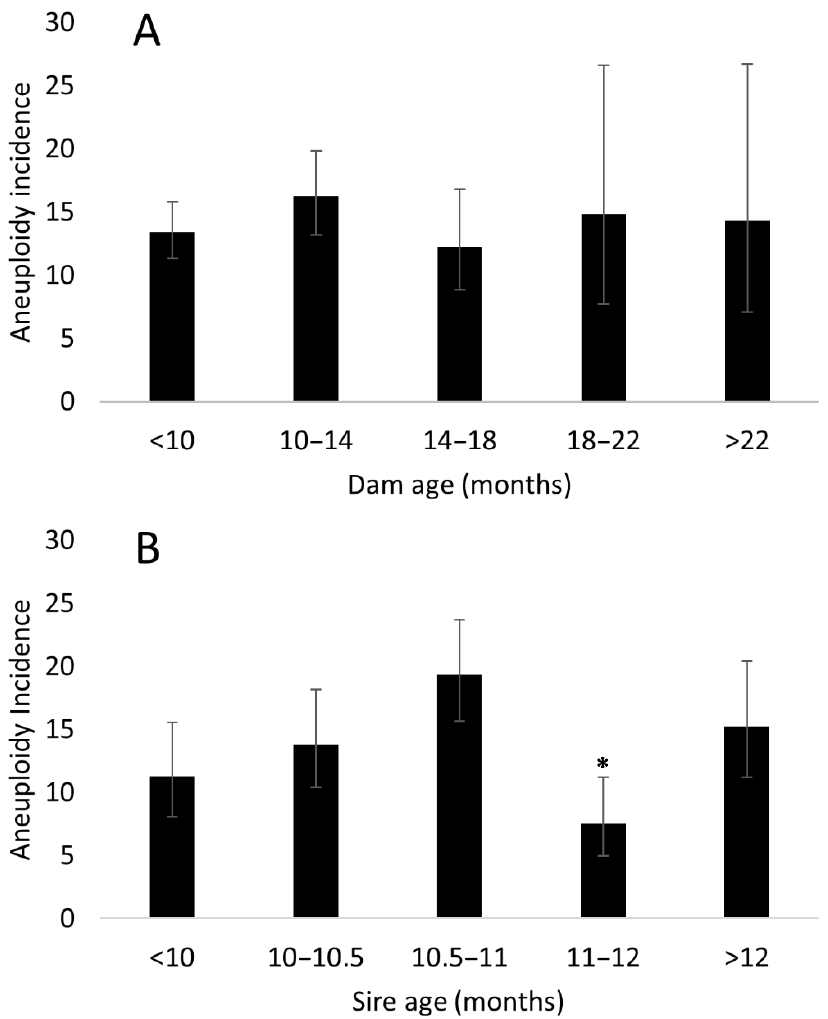
Figure 2. Embryo aneuploidy incidence by parent age. ( A ) Regression analysis showed no signifi- cant interaction between the age of the dam at oocyte collection and aneuploidy incidence in the resulting embryos (R 2 = 0.0142, p > 0.05). ( B ) Employing older sires did not negatively affect embryo ploidy; the star symbol (*) denotes a statistically significant ( p < 0.01) aneuploidy incidence decrease for that group as compared to all others. Data presented as percentage (%) with 95% C.I.